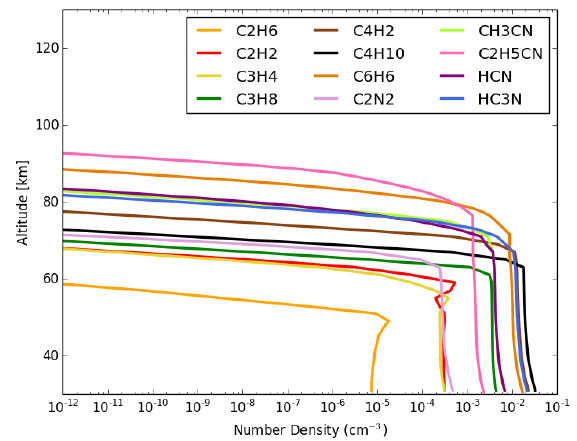
Figure 1. Ice condensation layers formed by many of the hydrocarbon and nitrile trace species found in Titan’s atmosphere.